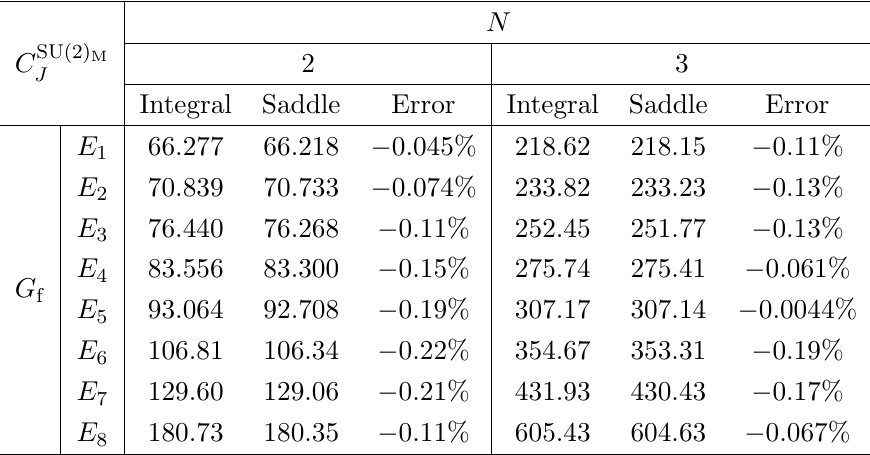
in the rank-one J